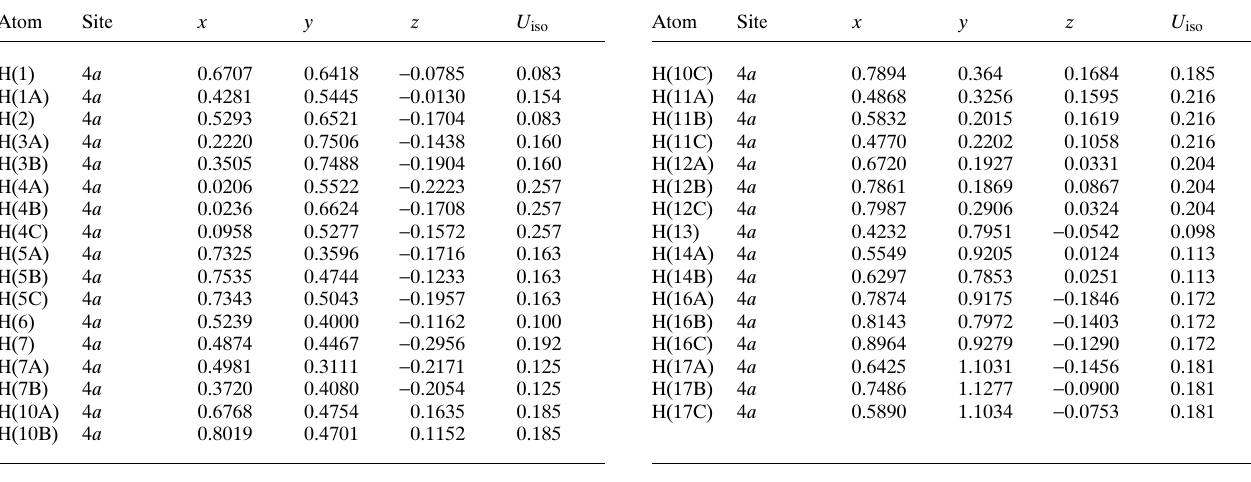
Table 2. Atomic coordinates and displacement parameters (in Å 2 )